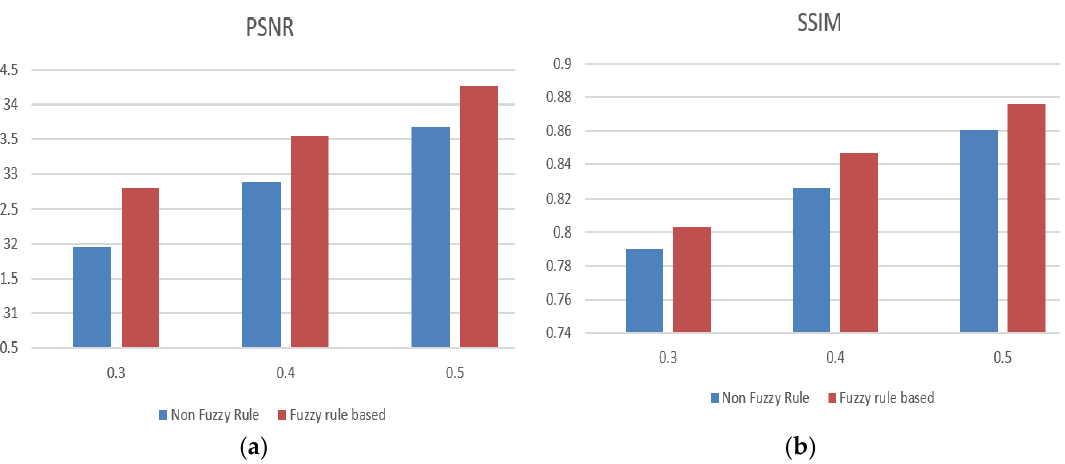
Figure 9. Performance comparison of the Fuzzy and Non fuzzy based approach in terms of ( a ) PSNR and ( b ) SSIM.